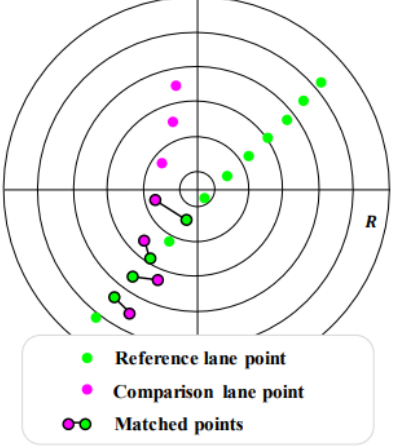
Figure 5. Illustration of shell structure with continuous landmarks. The shell structure is partitioned by sectors surrounded by black lines. When the reference and comparison lane points exist together in each sector, they are matched in a way that minimizes the distance between two